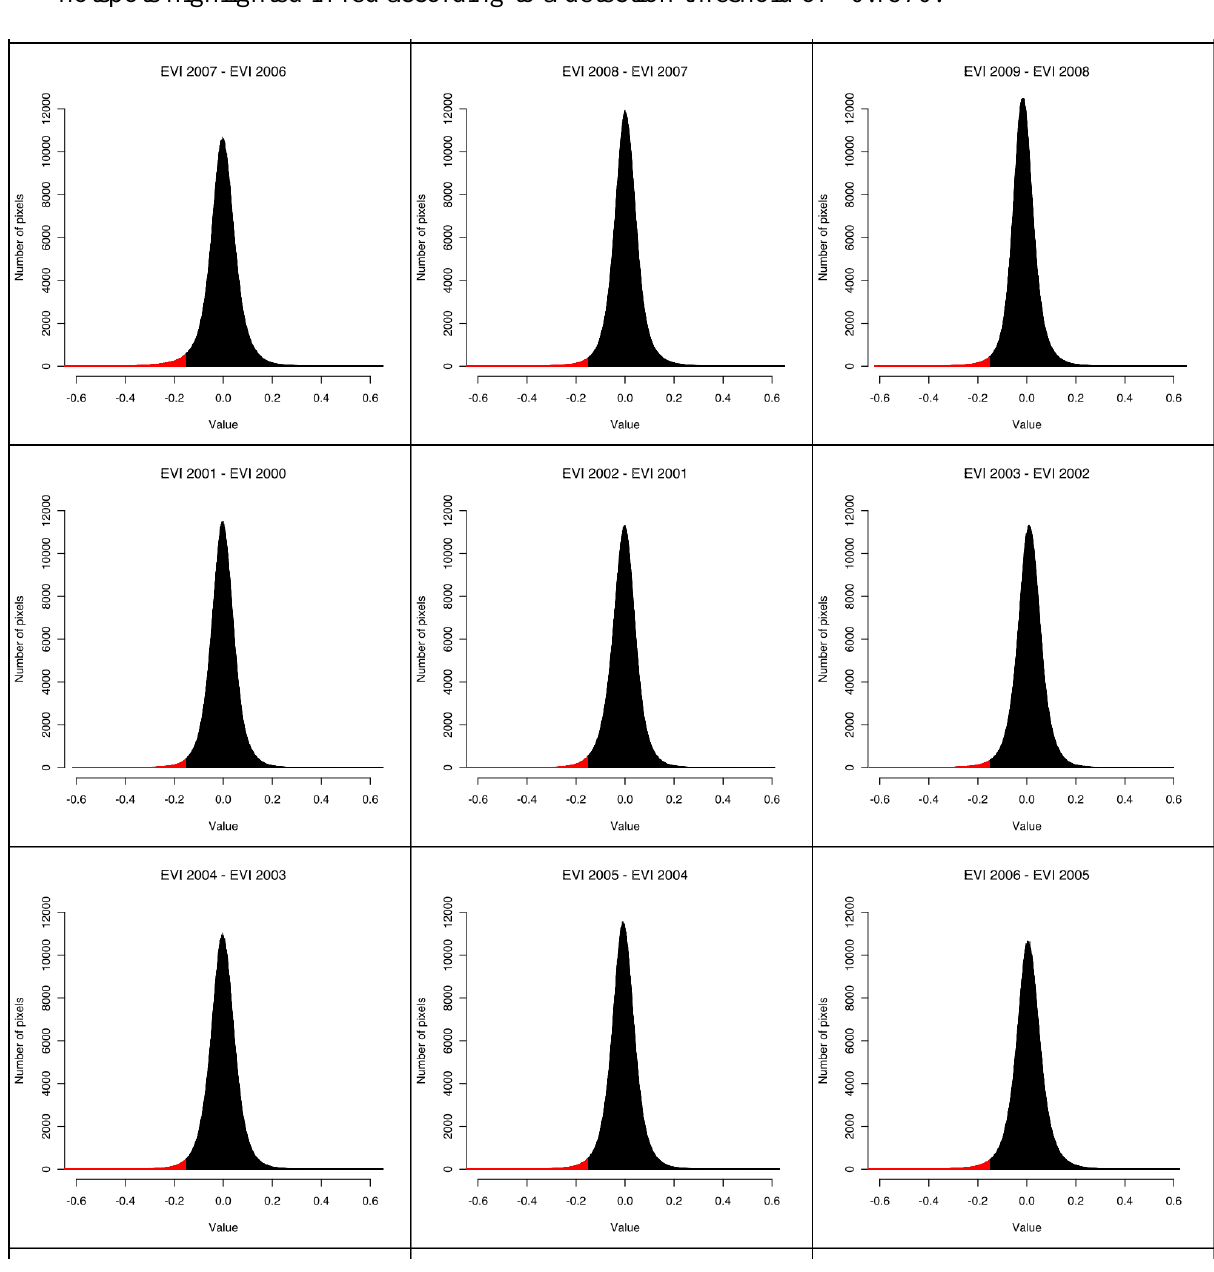
Figure 6. Histogram of the nine differentiated EVI images with pixels representing hotspots highlighted in red according to a detection threshold of